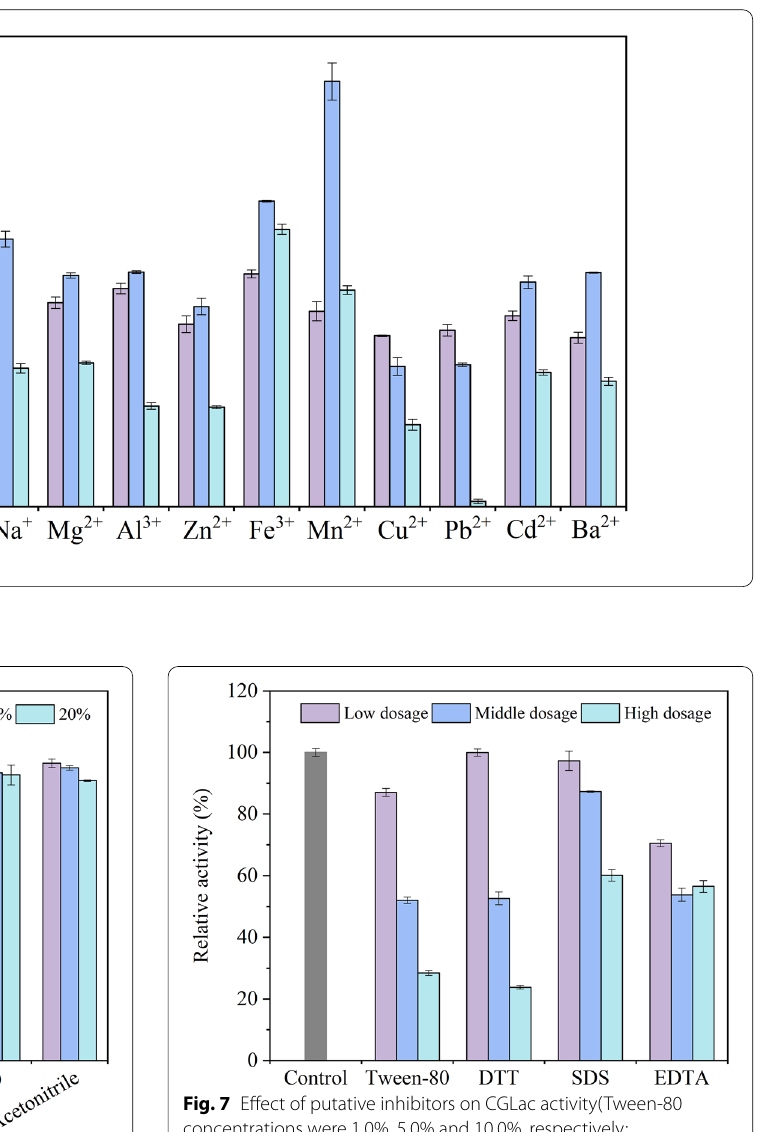
Fig. 6 Effect of common organic solvents on CGLacactivity